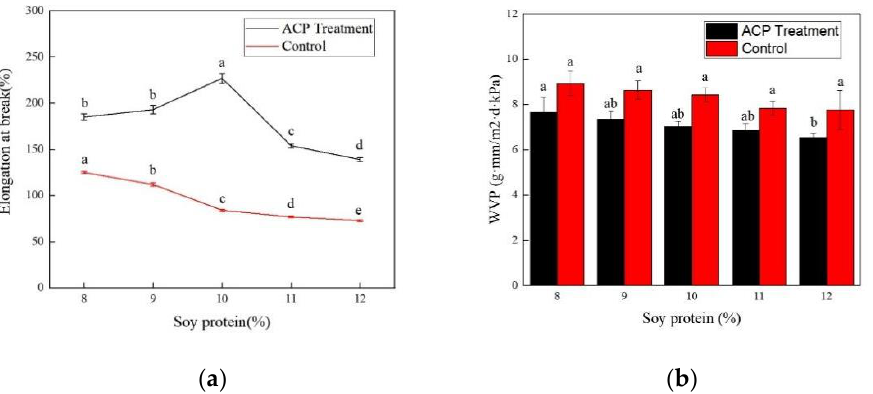
Figure 2. Effect of soy protein concentration on mechanical properties of the film. ( a ) Elongation at break of ACP−treated and control group. ( b ) WVP of ACP−treated and control group. Different lowercase letters denote significant differences ( p < 0.05).